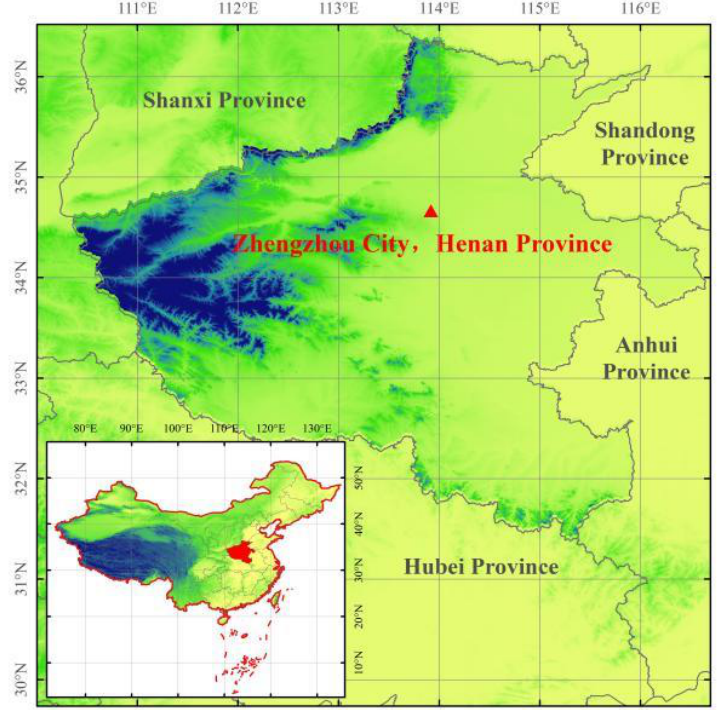
Figure 1. Location of the site (Zhengzhou) and topography in China.